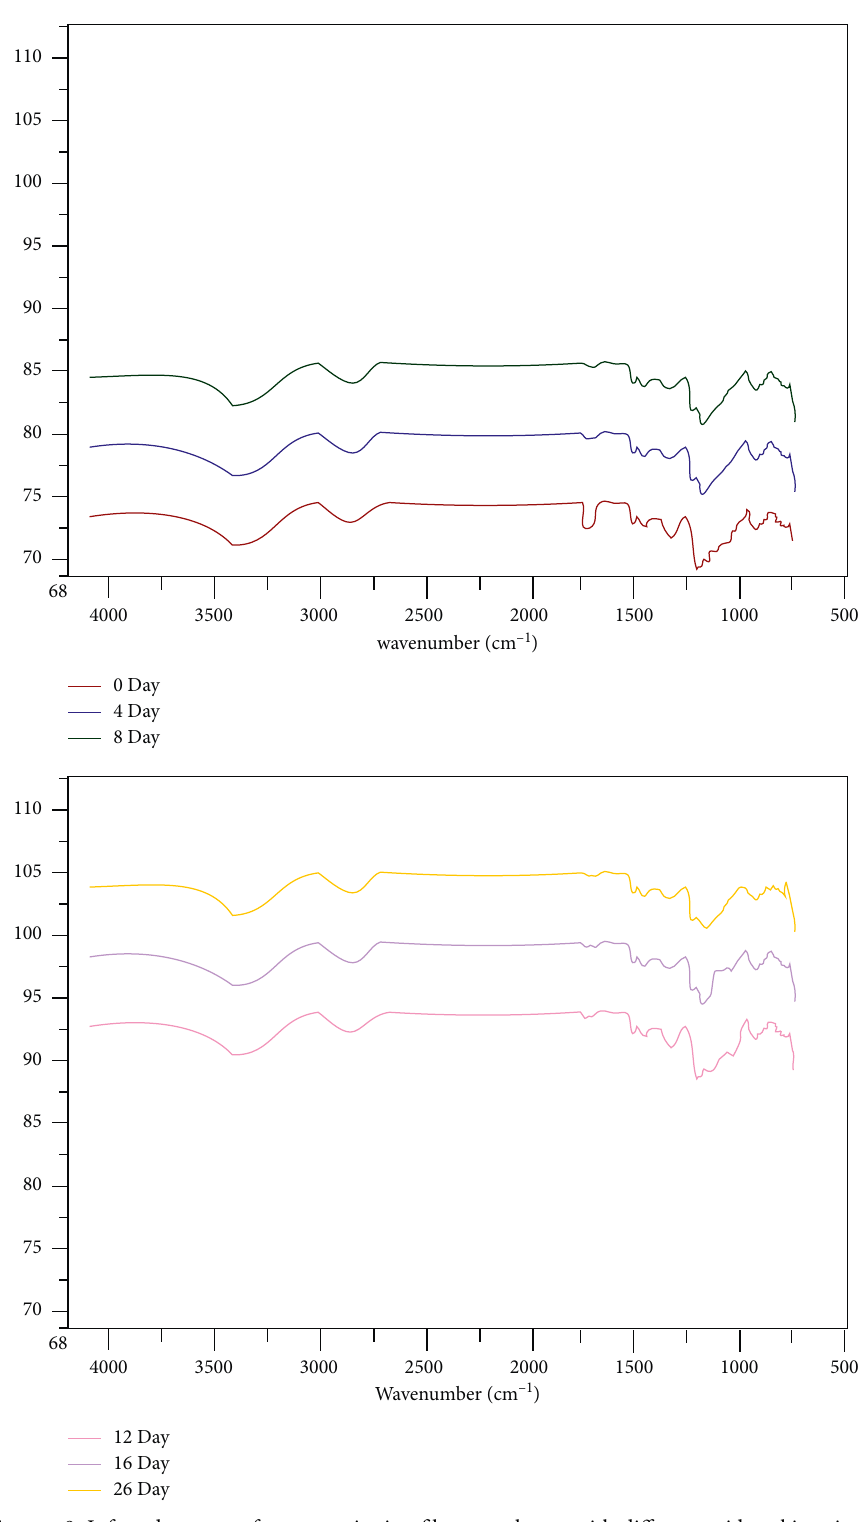
Figure 8: Infrared spectra of pva-ga spinning fiber membrane with different acid soaking